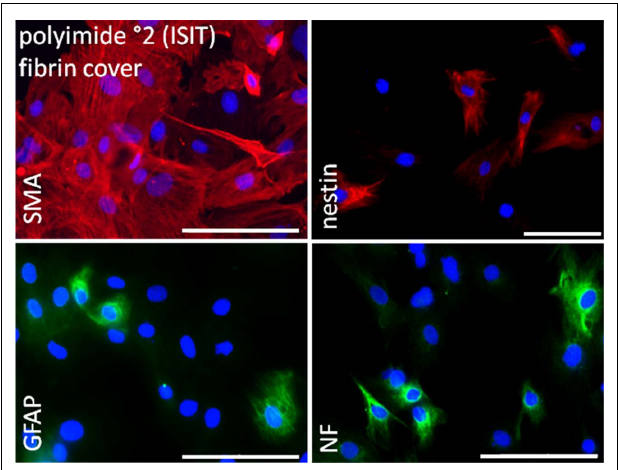
FIGURE 8 | Immunocytochemical analysis of rat pancreatic stem cells grown on polyimide˚2 film covered with fibrin. Cells are stained for alpha smooth muscle actin (SMA), glial fibrillary acidic protein (GFAP), nestin, and neurofilaments (NF). Secondary antibody in green was FITC-labeled goat-anti-rabbit and in red was Cy3-labeled goat-anti-mouse. The nuclear counterstaining was made with DAPI. Scale bars represent 100 μ m (Axio Observer.Z1, Carl Zeiss GmbH, Oberkochen, Germany).